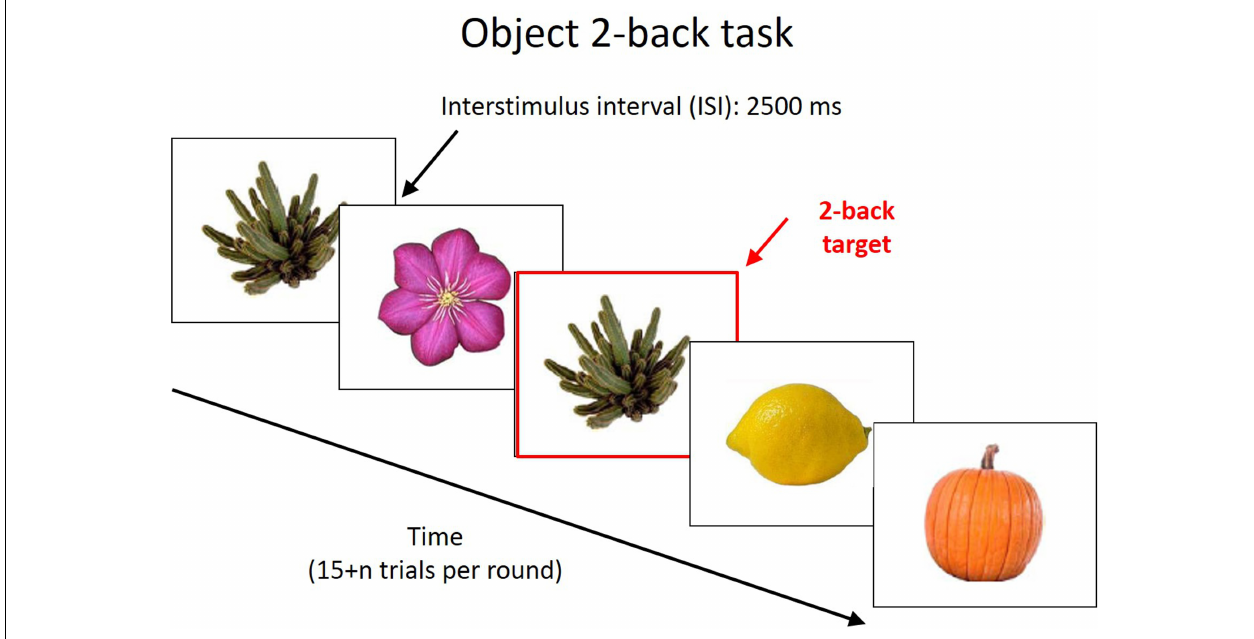
FIGURE 1 | Object 2-back task. Participants were presented with a sequence of pictures and they were instructed to indicate whether the current picture was the same as the one 2 pictures back in the sequence.